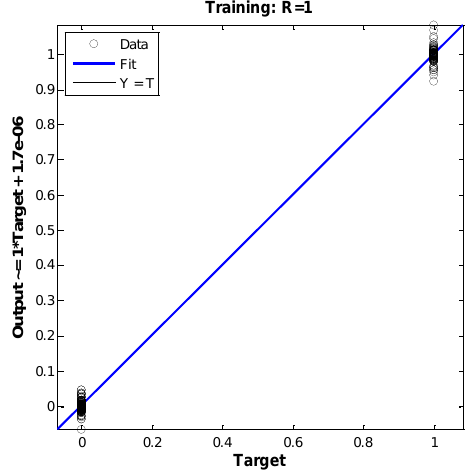
Figure 7. Regression of the ANN-BPSO optimization.